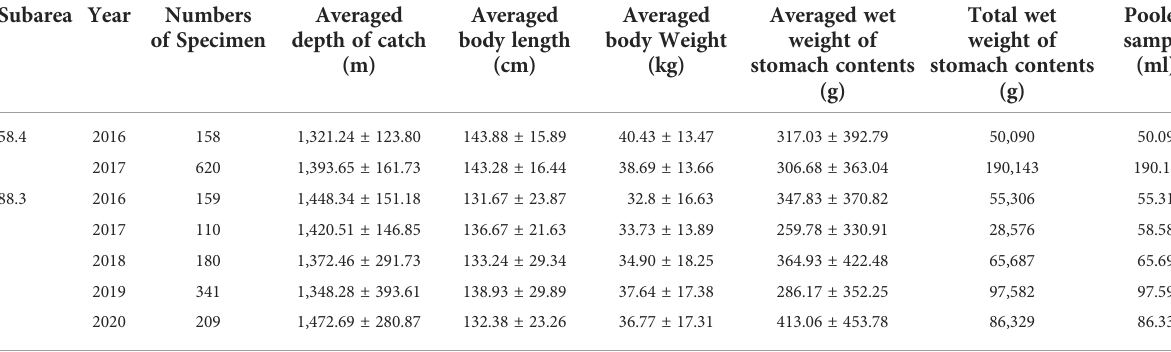
TABLE 1 Stomach samples of Dissostichus mawsoni used in this